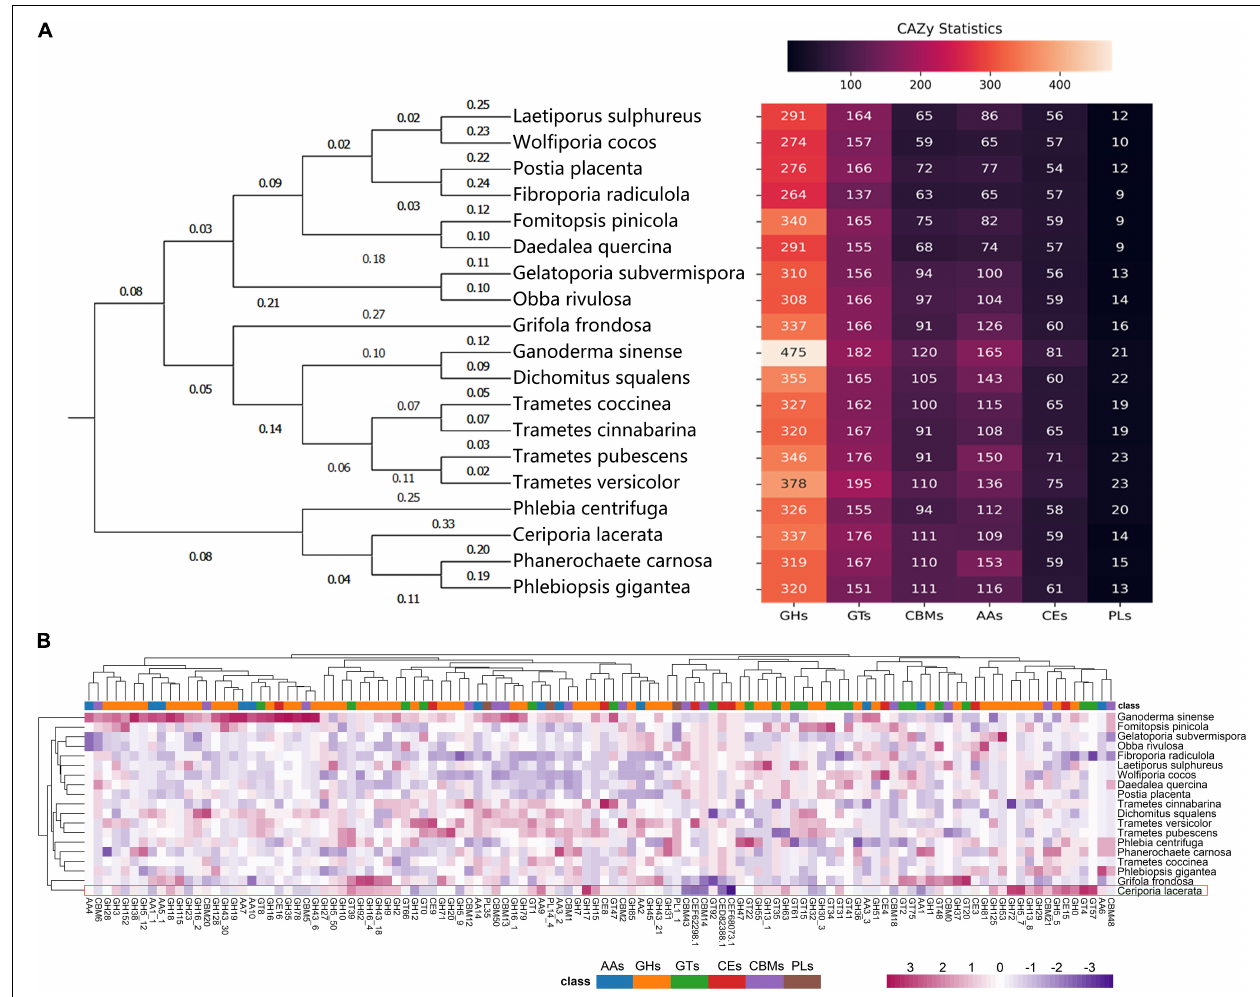
FIGURE 4 | CAZyme-encoding genes in the genome of Ceriporia lacerata identified using a comparative approach based on 18 additional species from the order Polyporales. (A) Gene counts and phylogenetic analysis of CAZymes. The phylogenetic tree was constructed with ML algorithm. (B) Gene count heatmap of CAZyme subfamilies, and the color scale represents the count of the gene normalized by the Z-score method. The CAZyme annotation information of the analyzed species is listed in Supplementary Table 2